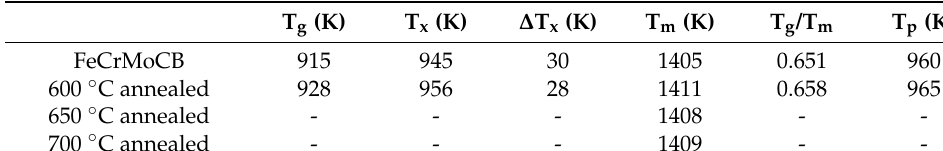
Table 2. Related temperature parameters calculated from DSC curves.